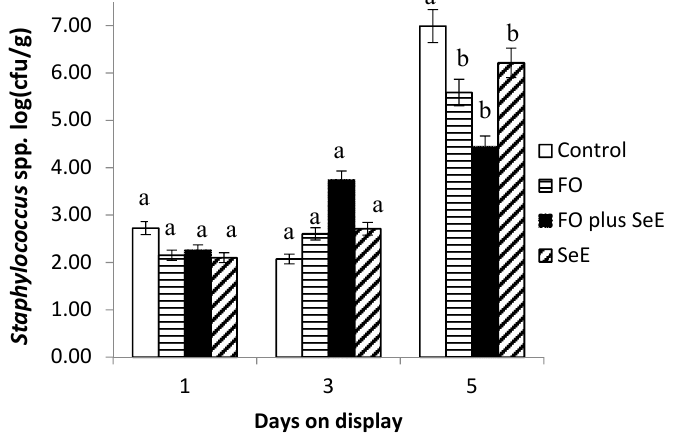
Figure 4. Mean log counts of Staphylococcus spp. obtained for the di ff erent treatments according to days on display; a, b—treatments in the same time point, followed by di ff erent lowercase letters, di ff er significantly at the 5% level.